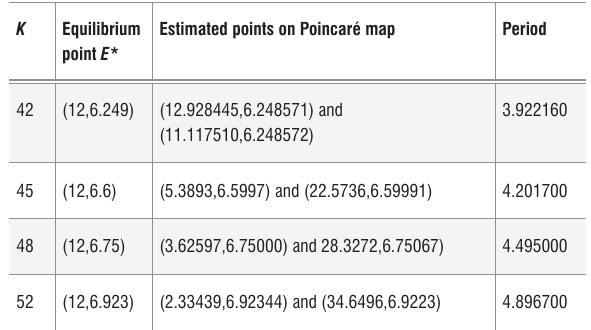
Note that each value of K ≥ 42 is associated with its unique equilibrium point and at least one limit cycle, of which the period can be estimated from the population–time graphs, confirming calculations using T H = 2 π aD + c rc ( aD – c ) suggested by Kuznetsov et al. 12 The equilibrium point and period of the limit cycle associated with various values of K are given in Period and points on limit cycles associated with chosen values of K > 42 Estimated points on Poincaré map Period K Equilibrium point E*